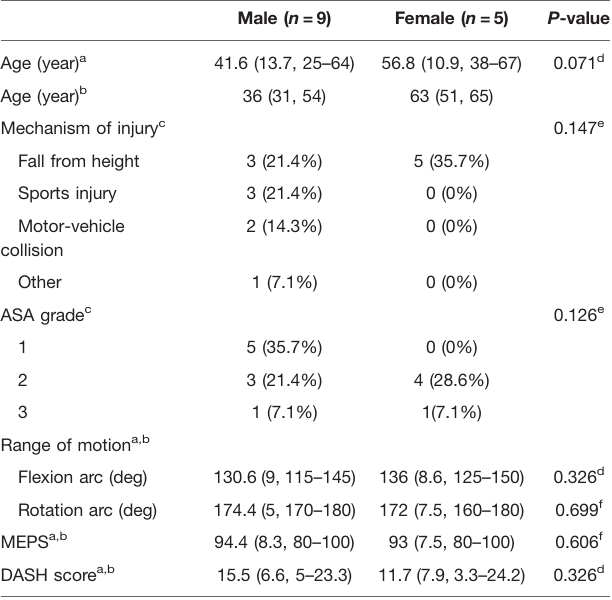
TABLE 2 | Patient demographics and